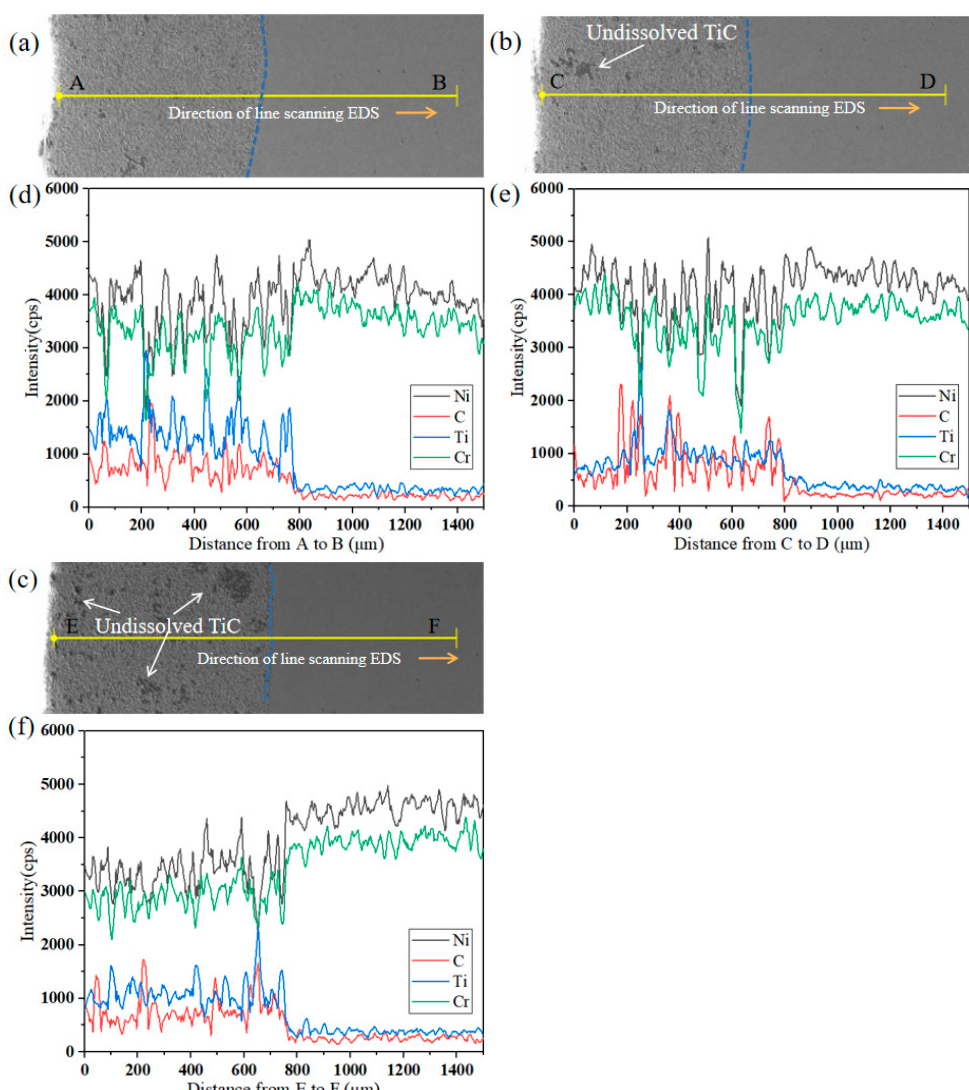
Figure 3. Alloy zone (AZ) and heat-affected zone (HAZ) line scan images: ( a ) and ( d ) C80, ( b ) and ( e ) C100, ( c ) and ( f ) C120.